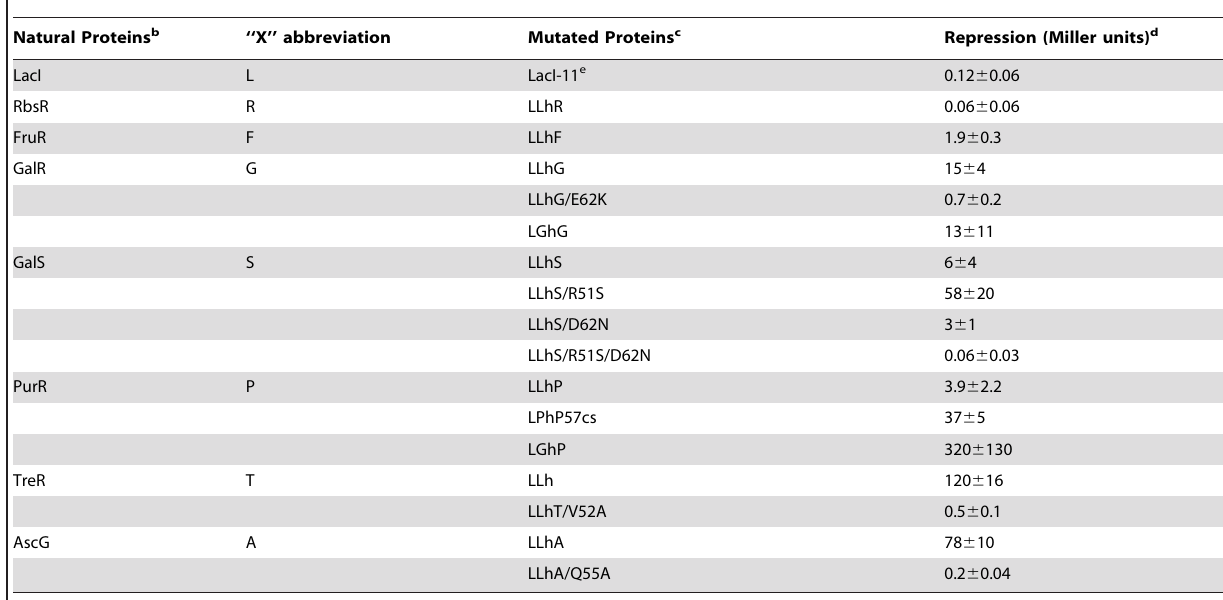
Table 1. Wild-type LacI/GalR proteins used to create the LXhX a chimeras.